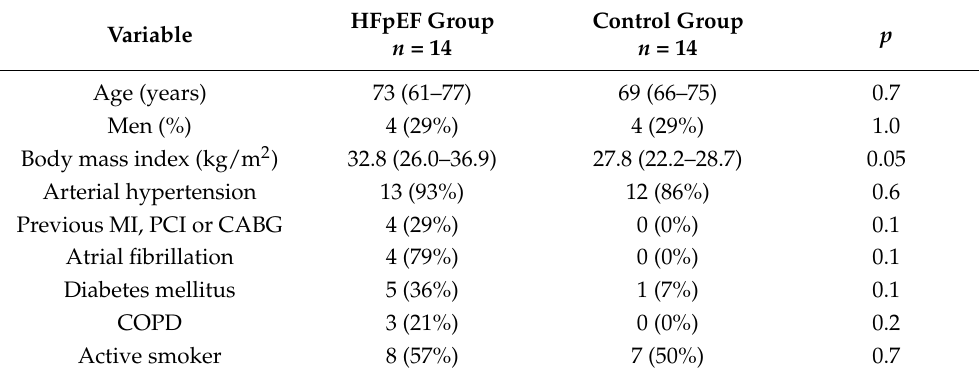
Table 1. Baseline characteristics of study